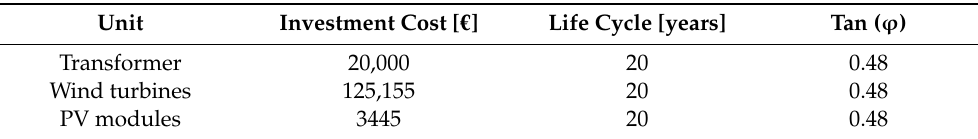
Table 2. Investment data.